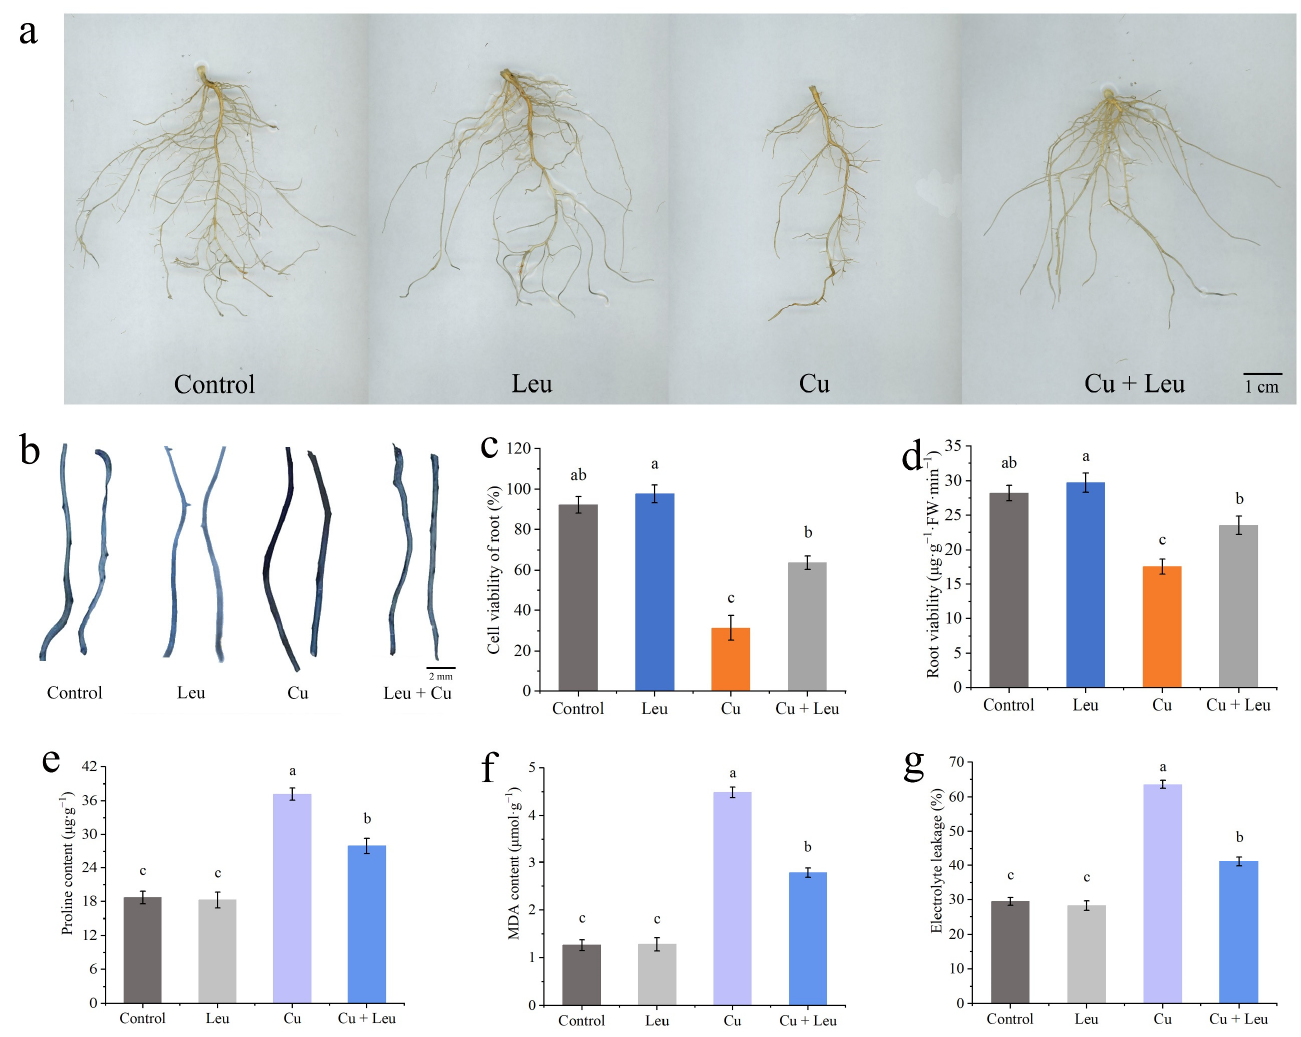
Figure 5. Effects of different treatments on root biomass, root cell viability, root viability, proline, malondialdehyde content, and electrolyte leakage of peach seedlings. ( a ) Root biomass; ( b ) Evans blue staining of roots; ( c ) root cell viability; ( d ) root viability; ( e ) proline content; ( f ) MDA content; ( g ) electrolyte leakage. Error bars represent standard deviations of the means ( n = 3). Different lowercase letters indicate significant differences among different treatments (Duncan test, p <